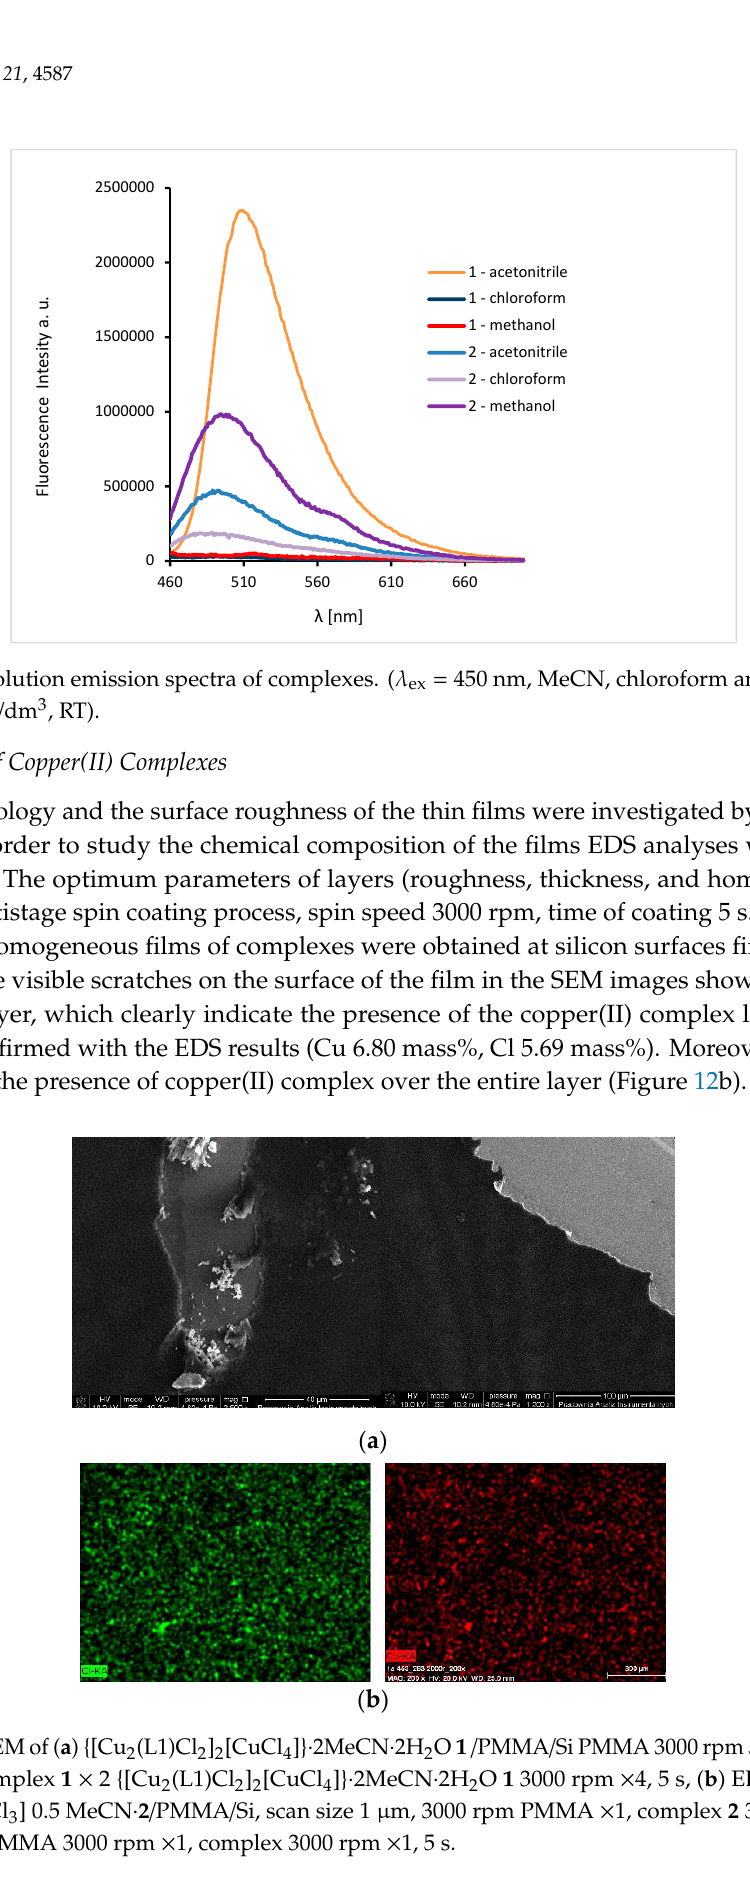
height Figure 13. AFM of {[Cu 2 (L1)Cl 2 ] 2 [CuCl 4 ]}·2MeCN·2H 2 O ( 1 ), PMMA/Si; PMMA ×1, PMMA + {[Cu 2 (L1)Cl 2 ] 2 [CuCl 4 ]}·2MeCN·2H 2 O ( 1 ) × 1, {[Cu 2 (L1)Cl 2 ] 2 [CuCl 4 ]}·2MeCN·2H 2 O ( 1 ) ×5, 2000 rpm 5 s scan size 1 μm, height (thickness) 25 nm, R a = 8.85–19.9 nm, R q = 11.1–25.9 nm. The fluorescence properties of the copper(II) complexes films were also studied. The emission of the copper(II) films was observed between 460–464 nm ( λ ex from 380 to 450 nm) and was connected